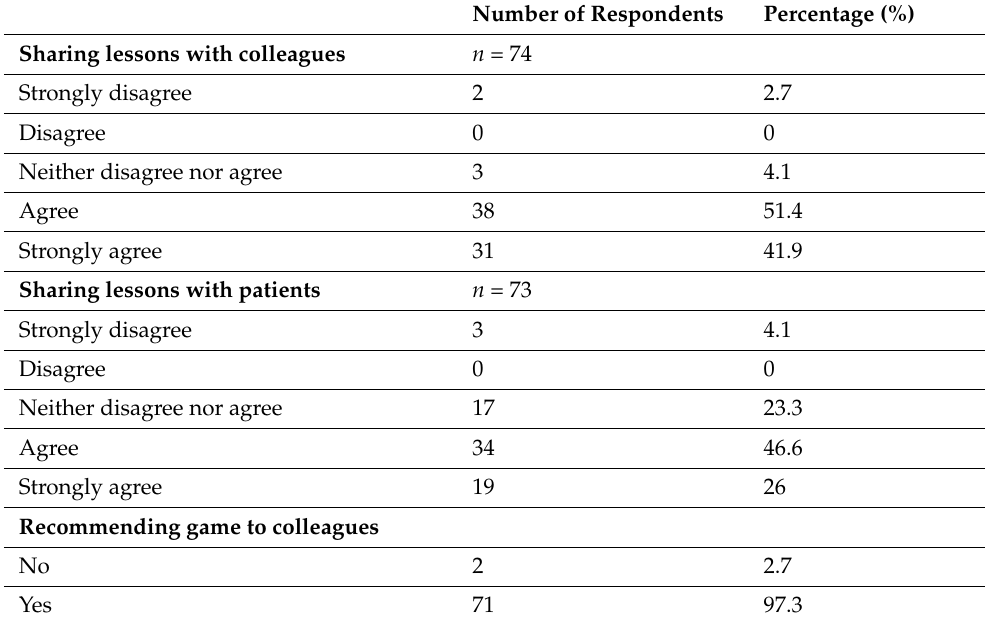
Table 6. Sharing lessons gained after playing the